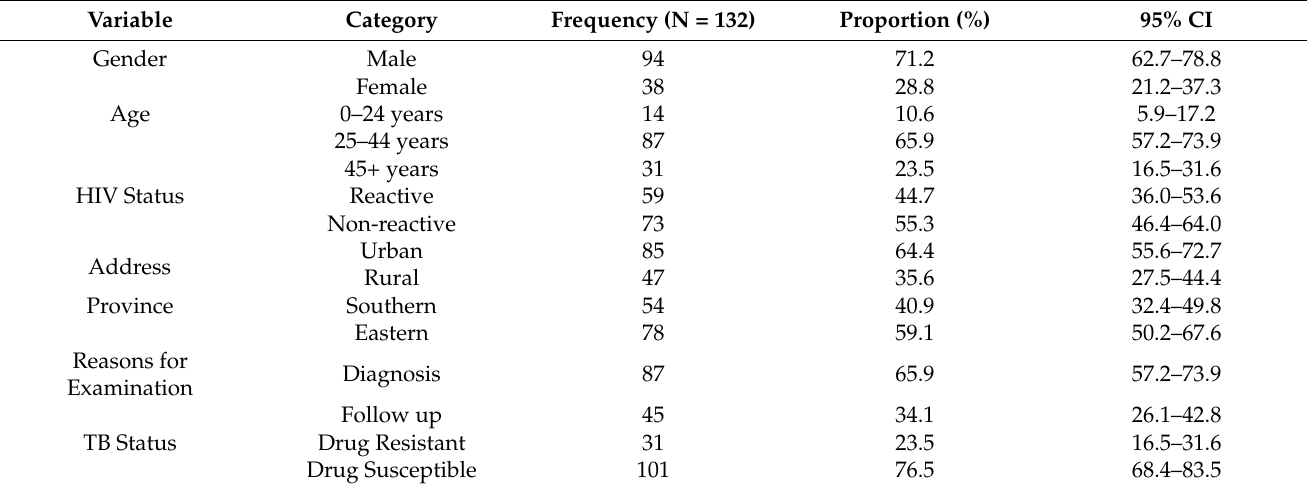
Table 1. Social–demographic characteristics of study participants.